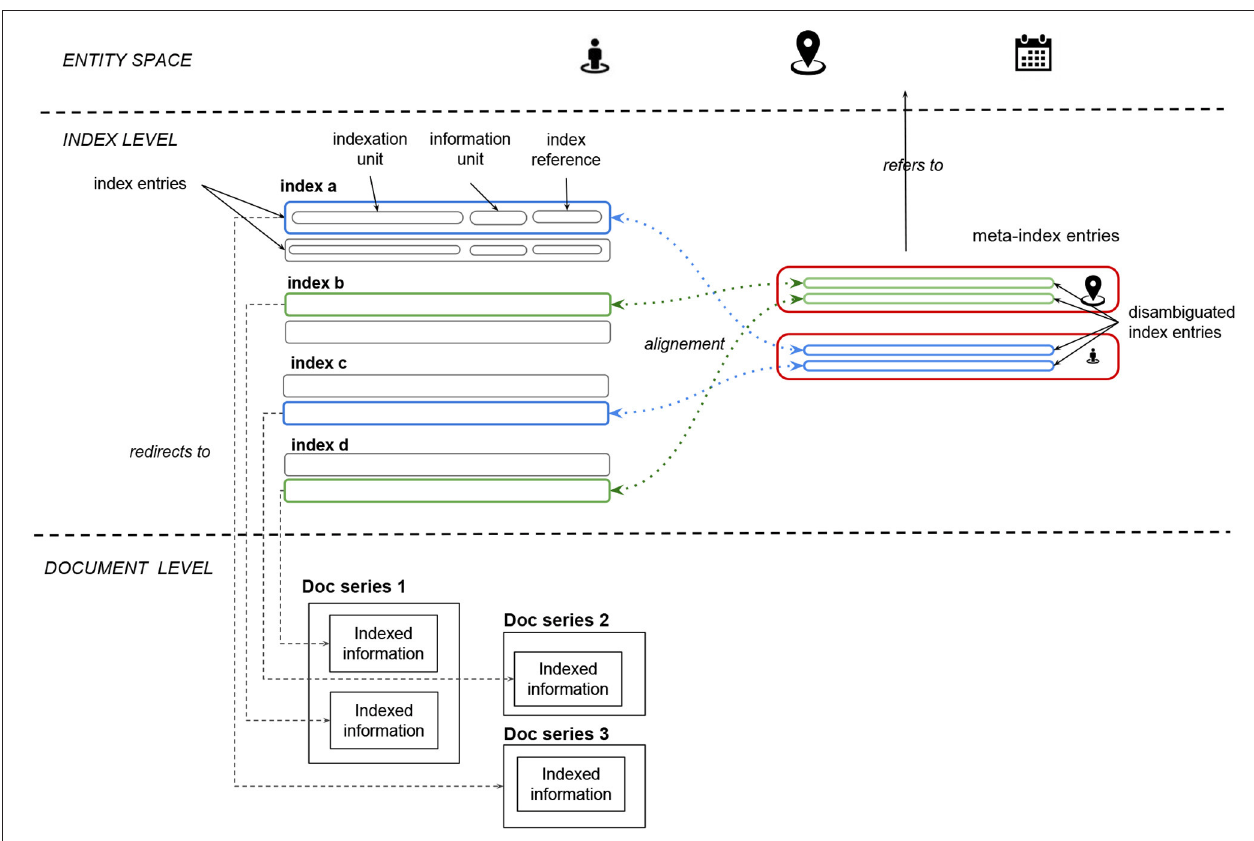
FIGURE 2 | A view of the conceptual model to describe historical